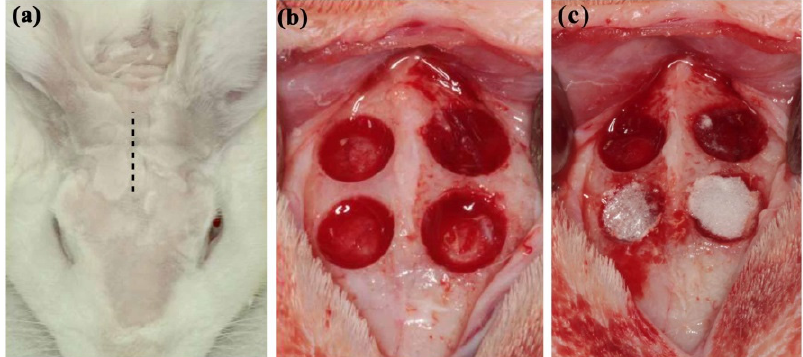
Figure 1. Animal model used in this study. ( a ) Before test, the surgical sites were shaved. ( b ) Four circular bone defects with a diameter of 6 mm were prepared on each rabbit skull. ( c ) Prepared defects were filled with HLA/CMC hybrids.